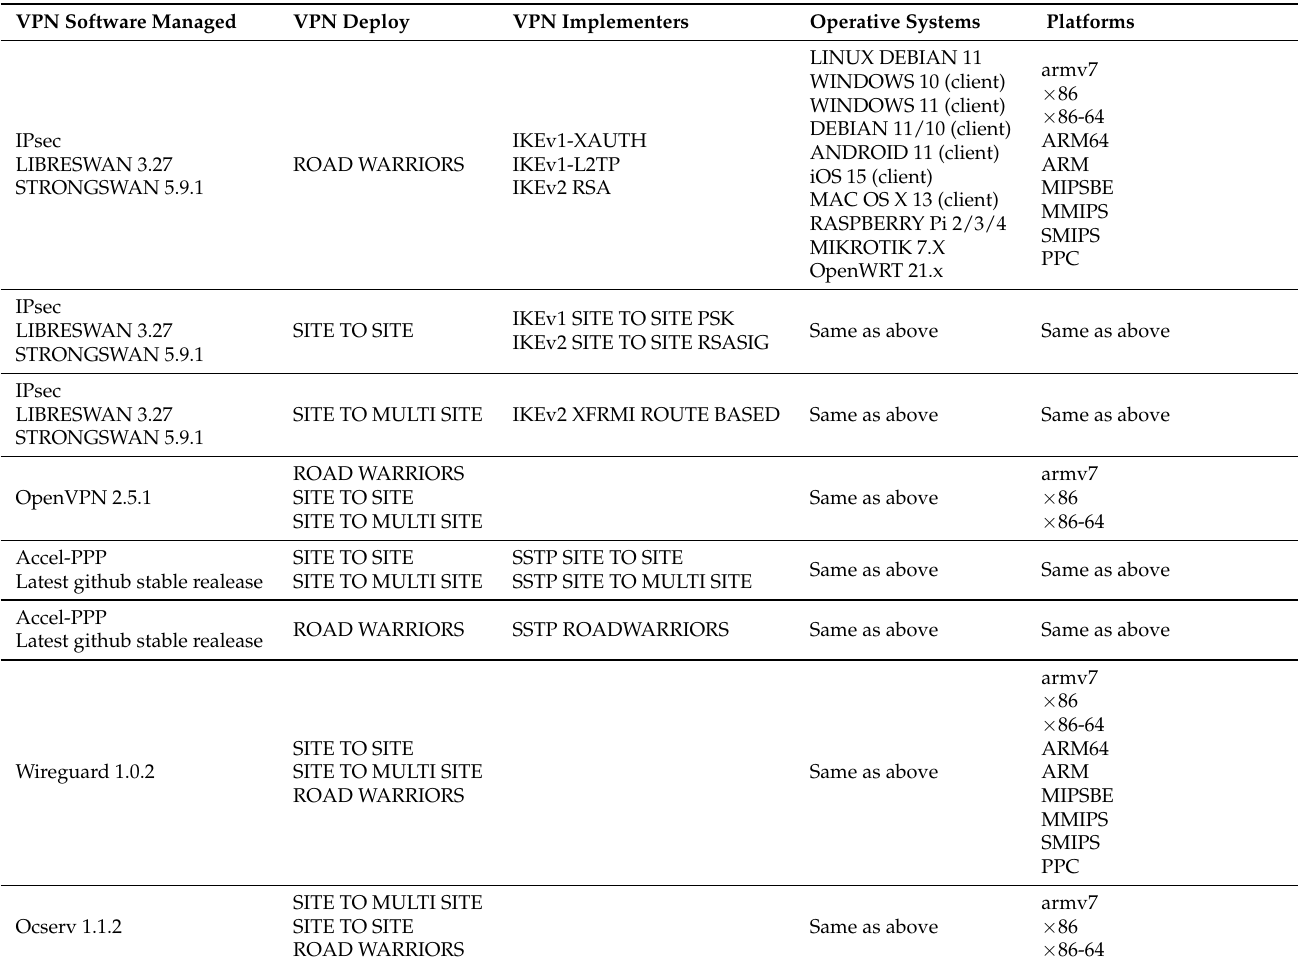
Table 2. A summary of the implemented testbeds.